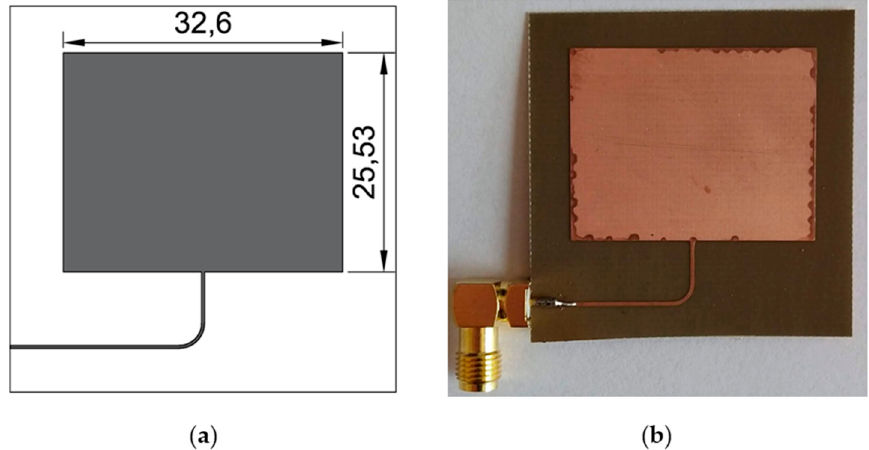
Figure 3. Rectangular microstrip strain sensor; ( a ) view and dimensions (in mm) of rectangular microstrip strain sensor; ( b ) photo of manufactured rectangular microstrip patch strain sensor (MPSS).